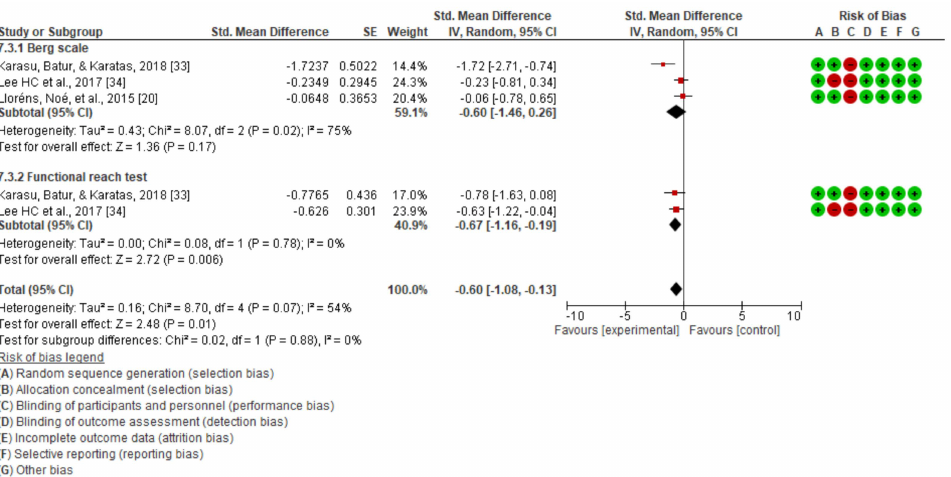
Figure 9. Meta-analysis of follow-up on static